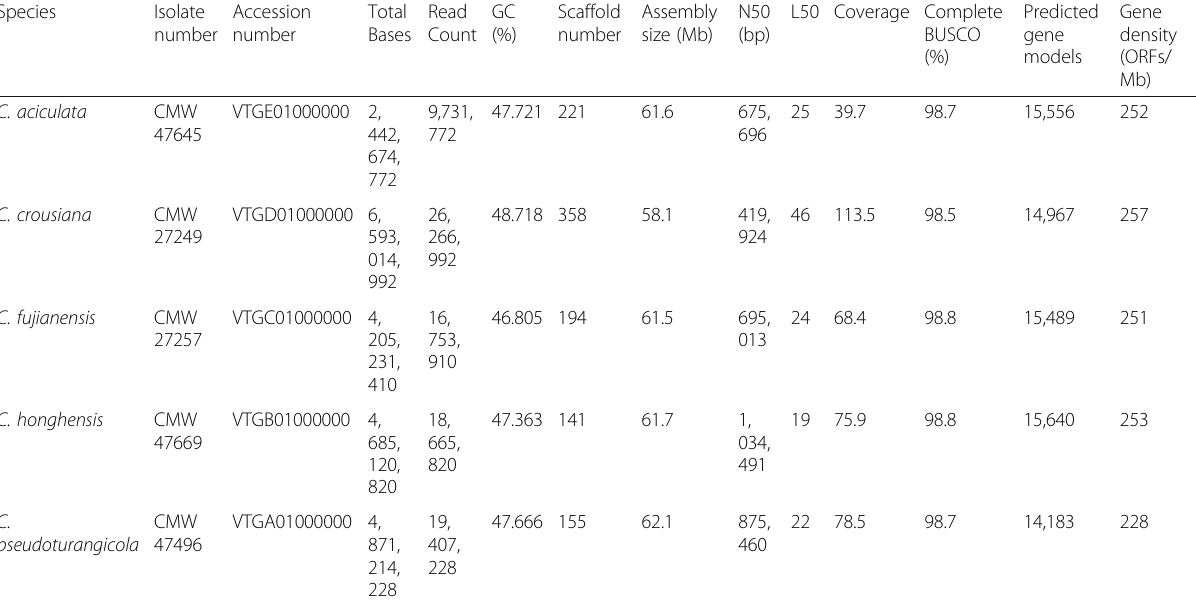
Table 1 Statistics of Calonectria genomes sequenced in this study